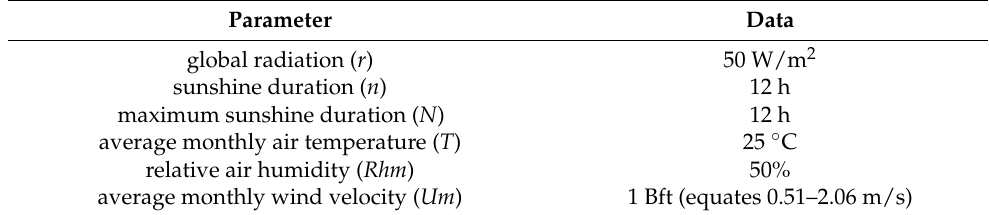
Table 6. Data for comparing the newly developed equation with the already existing equation of radiation by Makkink. Parameter Data global radiation ( r ) 50 W/m 2 sunshine duration ( n ) 12